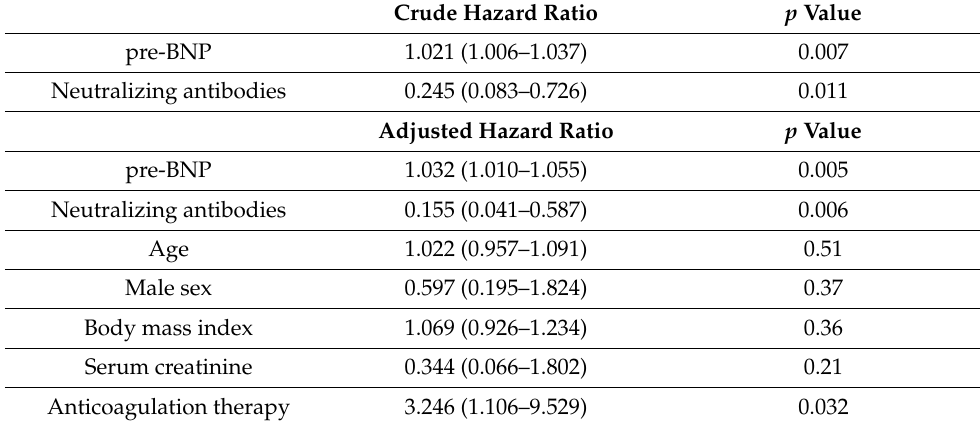
Time to event was analyzed using a Cox proportional-hazards model using Schoenfeld residuals after fitting. Hazard ratios with 95% confidence interval are described as crude and adjusted hazard ratios for the possible confounders described. Table 3. Relationship between neutralizing antibody levels and various BNP ratios, ( A ) a change in the BNP ratio > 10 in Periods 1–2 compared with baseline, ( B ) a BNP ratio at baseline > 4.0 or ( C ) a BNP ratio > 10 in Periods